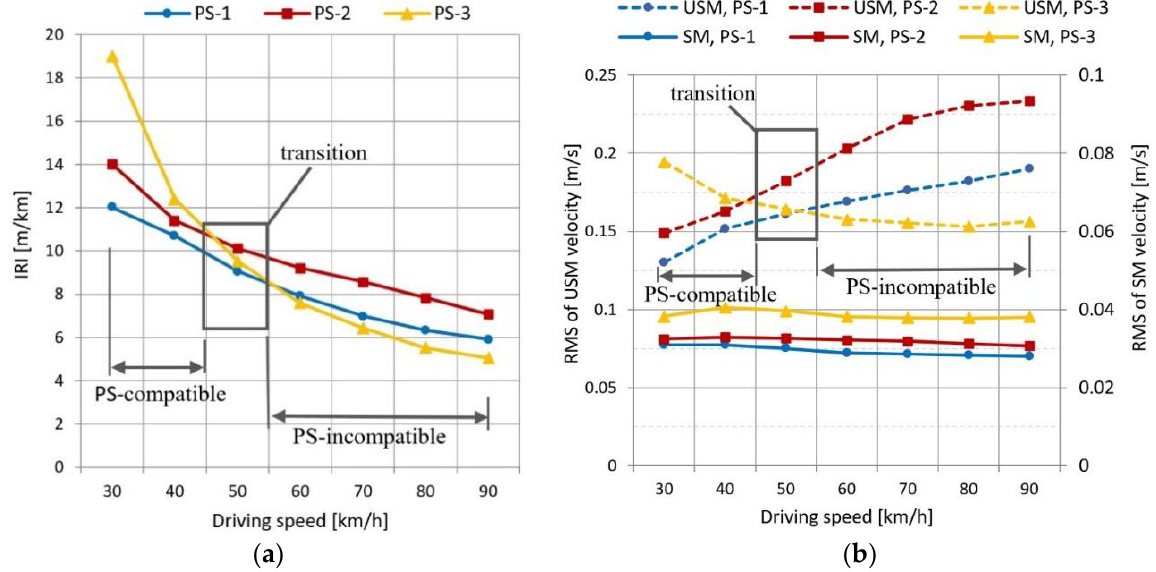
Figure 5. The analysis of IRI calculation sensitivity in line with calculation-applicable speed: ( a ) IRI values; ( b ) RMS values of SM and USM displacement velocity.